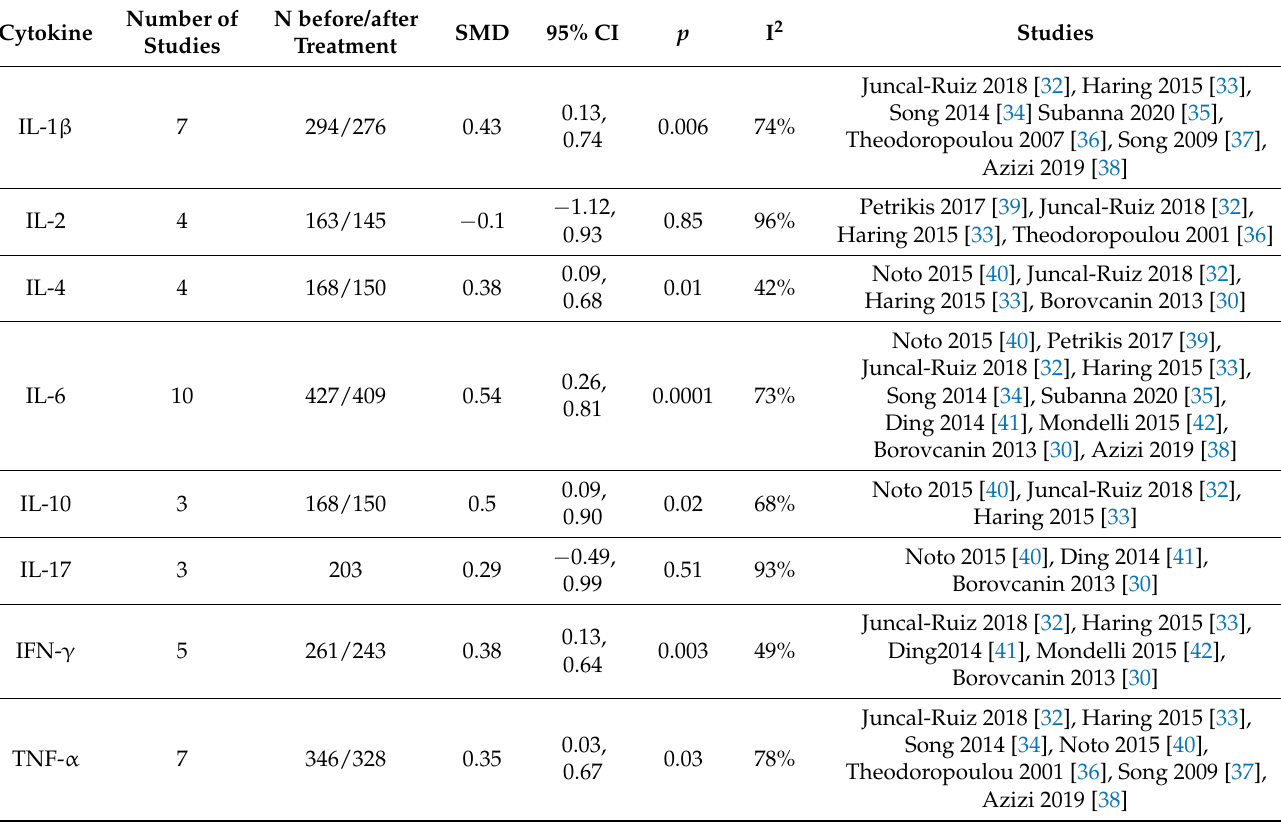
Table 1. Meta-analysis characteristics.